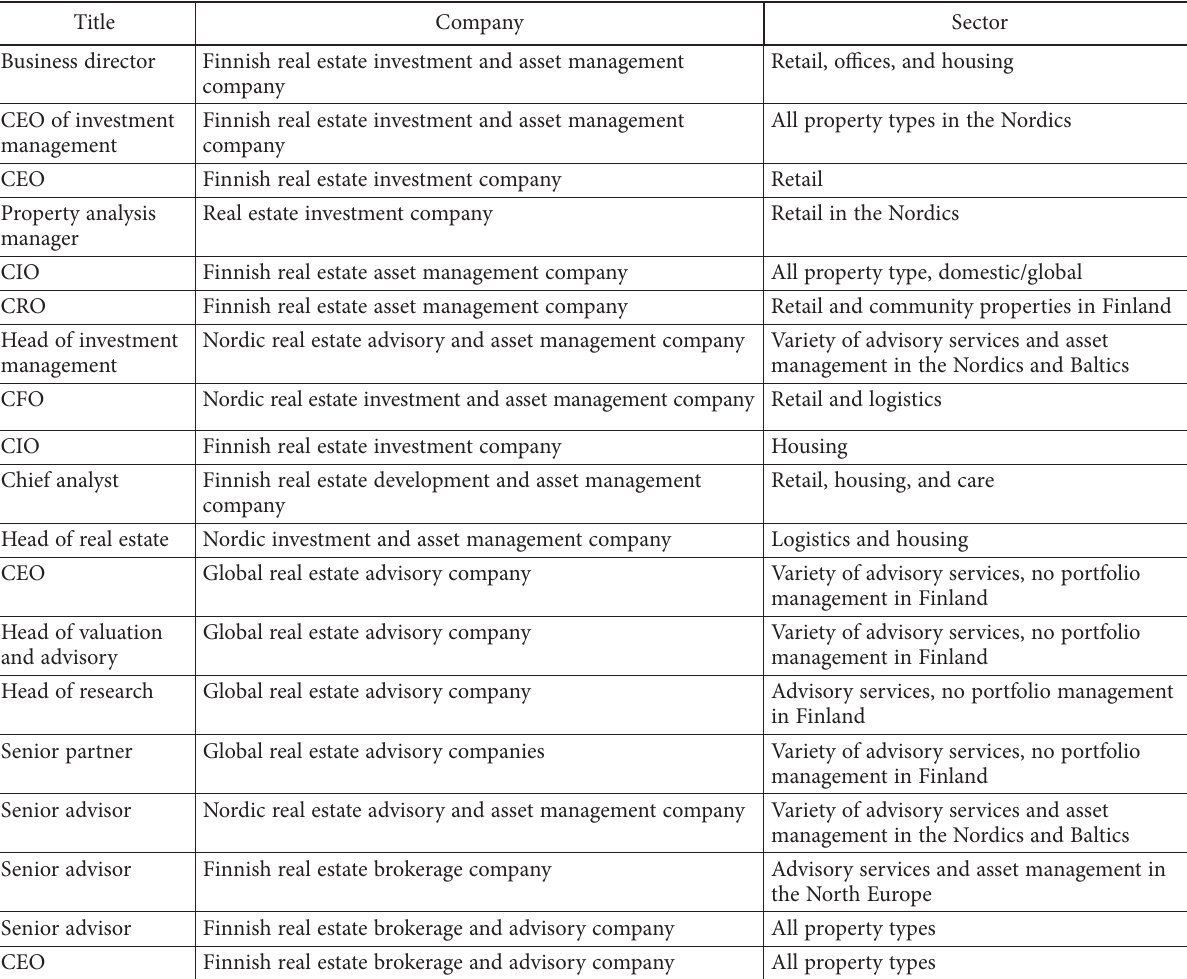
Table 1. Descriptive information of the interviewees (source: company